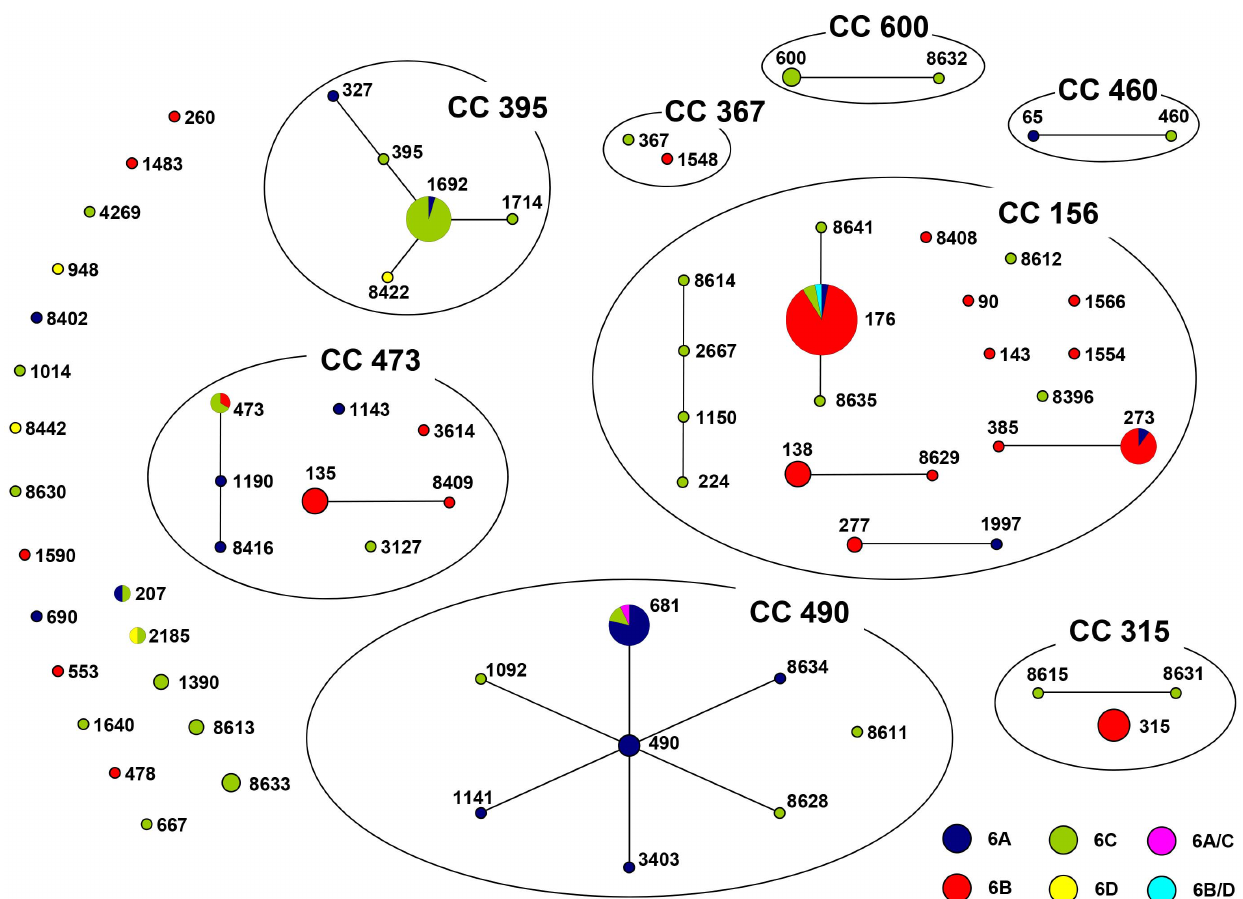
Figure 3. eBURST snapshot of serogroup 6 isolates from IPD in children and adults in Germany. Serotypes are color coded. Circles are proportional to the amount of isolates.